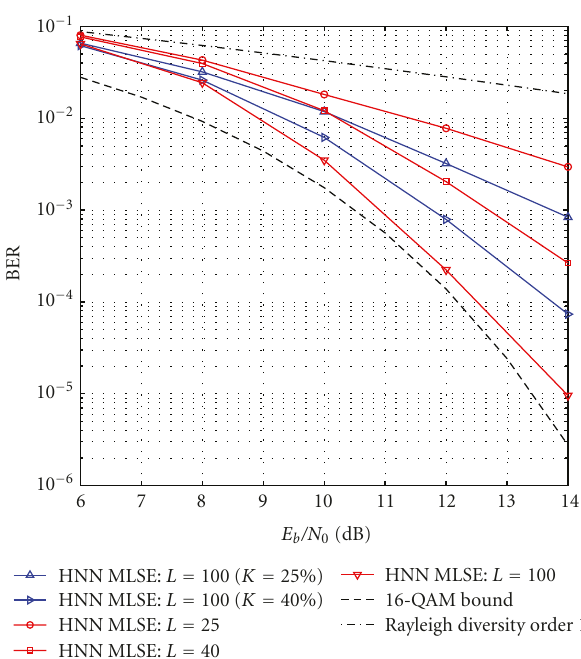
Figure 20: 16-QAM HNN MLSE performance in sparse channels with constant